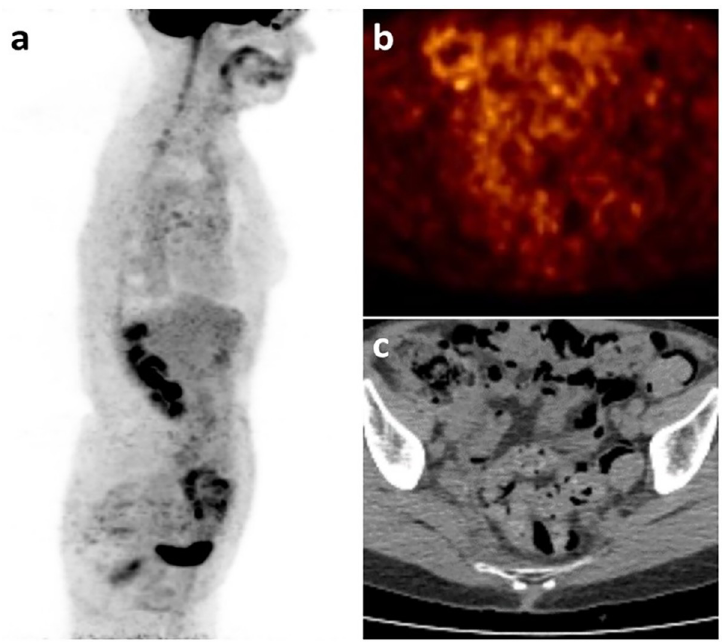
Fig 5. Peritoneal carcinosis undetected at PET/CT. Patient with locally advanced ductal breast carcinoma (pT2, N2a, M0) after surgery and 4 cycles of chemotherapy, under endocrine therapy. After suspicious rise in CA15-3 the patient underwent FDG-PET/CT, which showed no suspicious uptake and was reported as negative for distant metastases. Sagittal MIP (a) showed non-specific FDG uptake in the ascending colon and tracer excretion in the urinary tract. Pelvic axial cross-section of the FDG-PET/CT (b) and the co-registered CT image (c) did not show any suspicious uptake or measurable lesion.